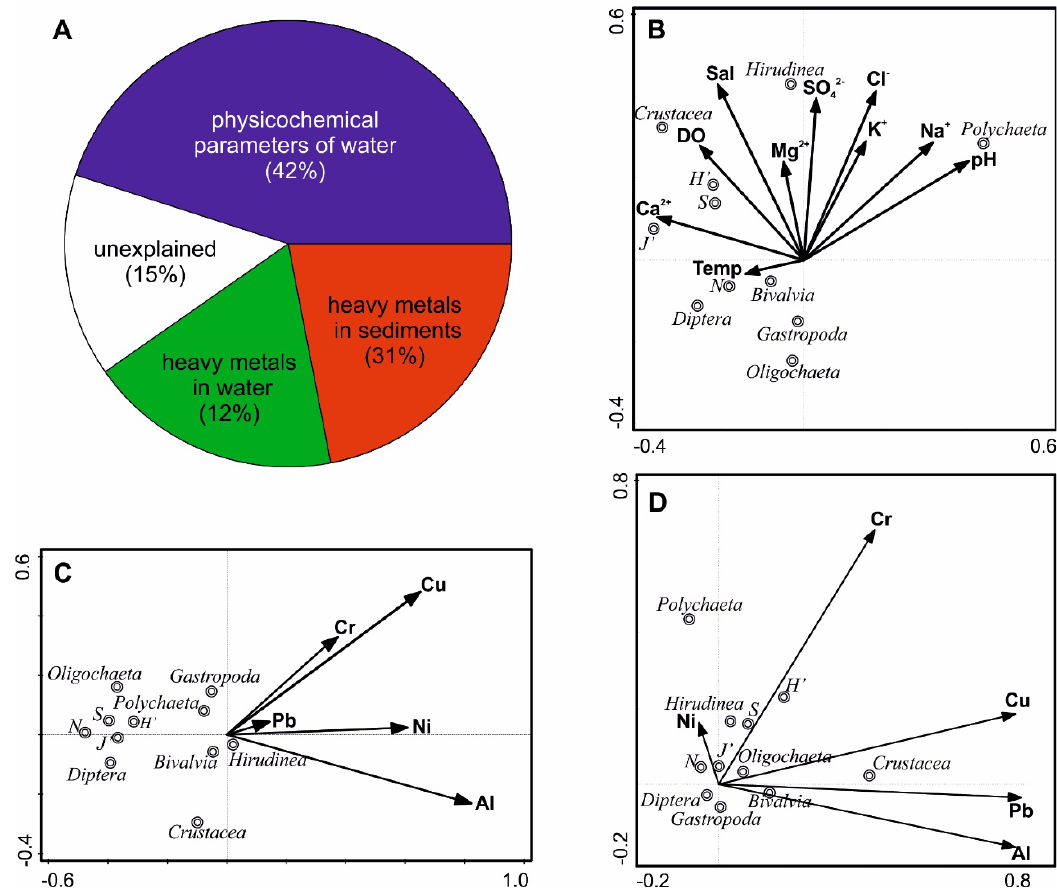
Figure 4. Unique and shared fractions (BIO-ENV procedure) of the total variation of invertebrates composition, explained by physico-chemical variables of water and the contribution of heavy metals in water and sediments ( A ). Results of RDA performed on bottom fauna and environmental data ( p < 0.05): physico-chemical variables of water ( B ), heavy metals in water ( C ) and sediments ( D ). Descriptors: explanations of the abbreviations as in Figure 3.